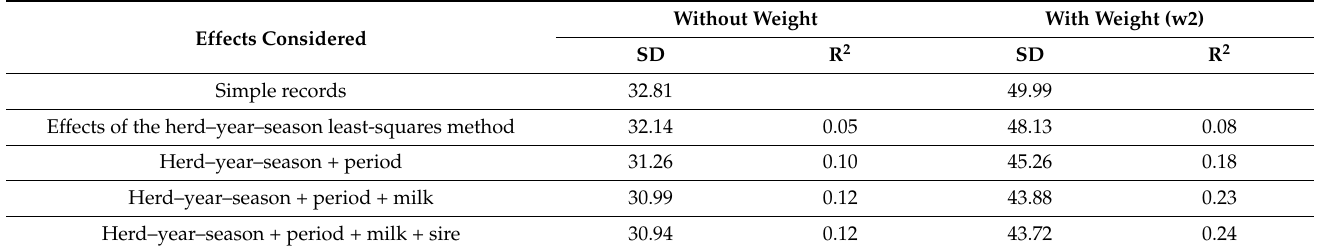
Table 3. Fixed effects—explained variability and survival standard